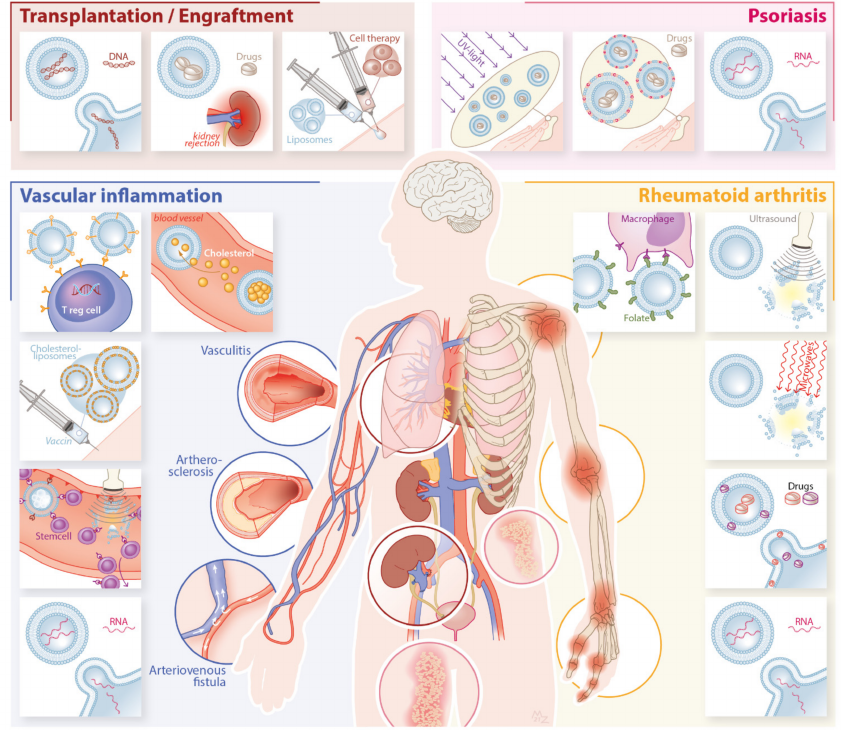
Figure 2. Summary of the innovative developments in liposomal treatment of the inflammatory con- ditions psoriasis, rheumatoid arthritis, vascular inflammation, and transplantation and engraftment. Innovations are presented per field and include developments in topical applications, RNA drug delivery, and PUVA therapy in psoriasis; codelivery of drugs and heat-responsive drug release in rheumatoid arthritis; cholesterol vaccination, induction of Tregs, and ultrasound-mediated drug release in vascular inflammation; and treatment of acute graft rejection in